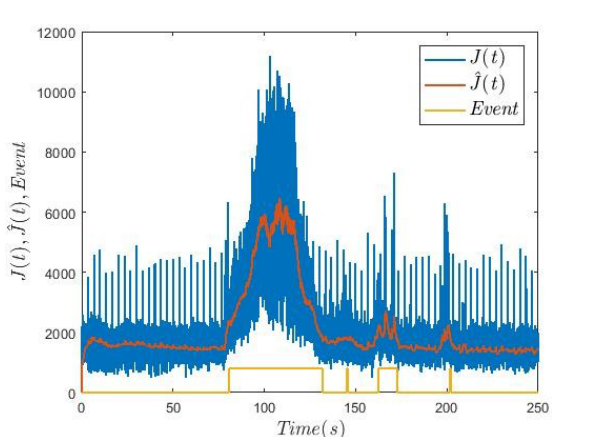
Figure 3. Graphs of the